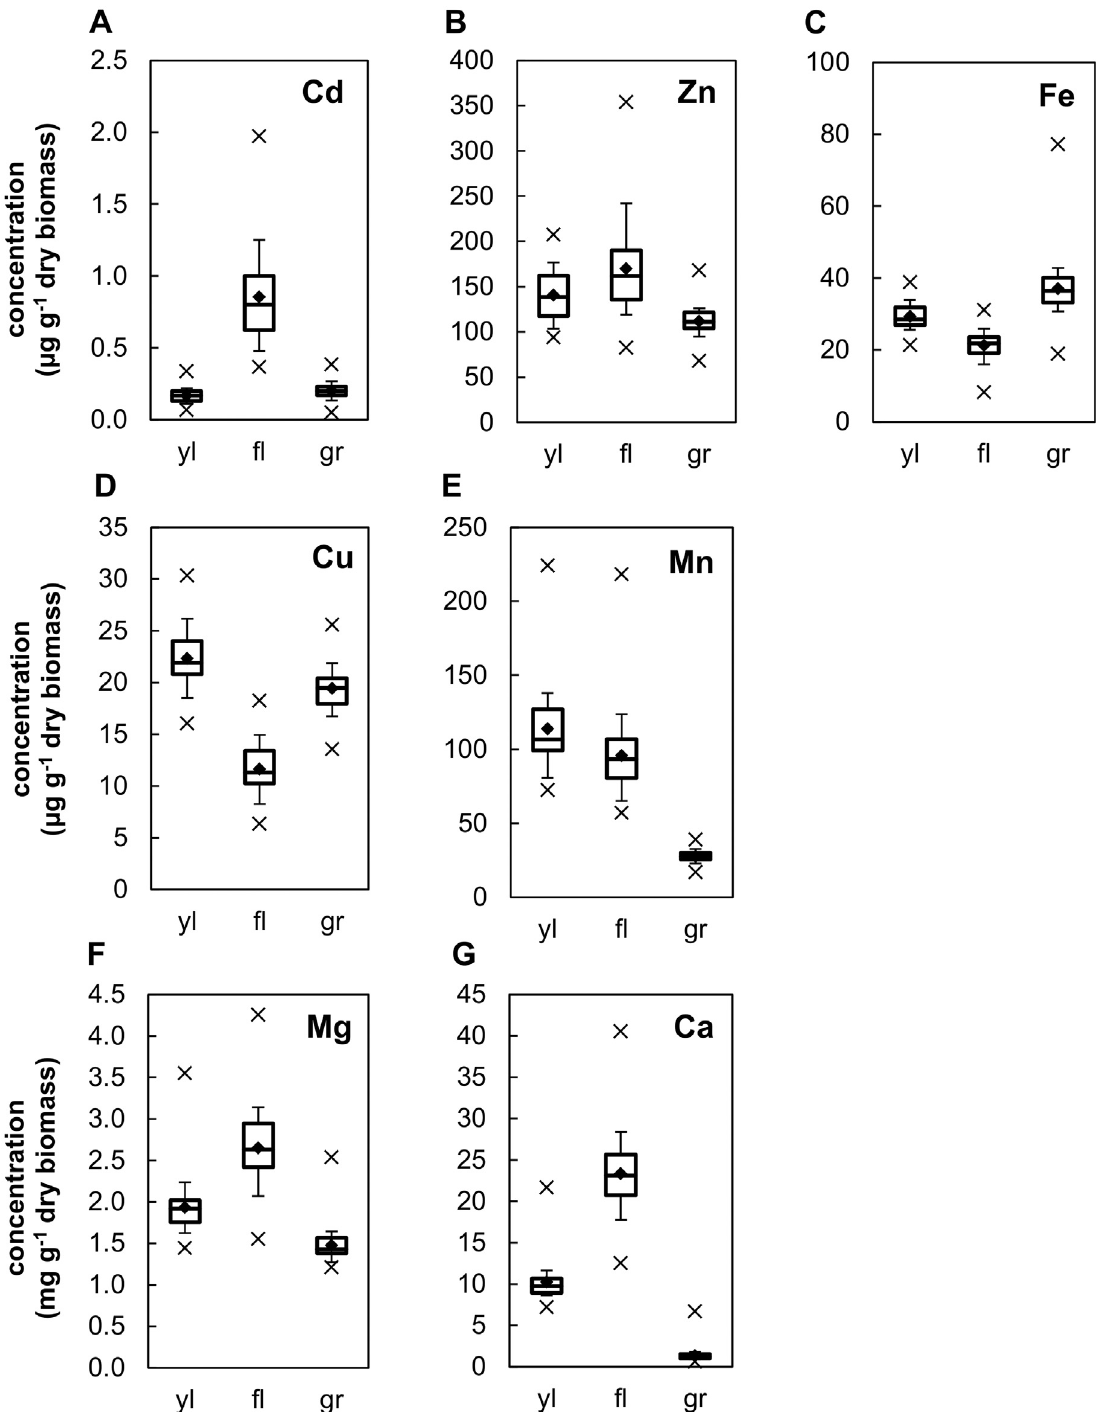
Fig 1. Element accumulation in tissues of barley introgression lines. Concentrations of (A) Cd, (B) Zn, (C) Fe, (D) Cu, (E) Mn, (F) Mg, and (G) Ca are shown in boxplots summarizing least-square means of the 54 ILs and the recurrent parent Scarlett, for young leaf (yl), senesced flag leaf (fl) and grains at maturity (gr) of plants grown on a contaminated soil. Diamonds represent arithmetic means calculated from all 55 genotypes, 25-to-50-to-75 and 10-to-90 percentiles are represented by boxes and whiskers, respectively, and minimum and maximum values are shown as cross symbols. Plants were cultivated in a greenhouse on a soil collected in a heavy-metal contaminated agricultural field, with harvest of yl at the five-leaf stage and harvest of fl and gr at maturity. Note that concentrations of the macronutrients Mg (F) and Ca (G) are plotted on a different scale. Each measurement was conducted on pooled tissues